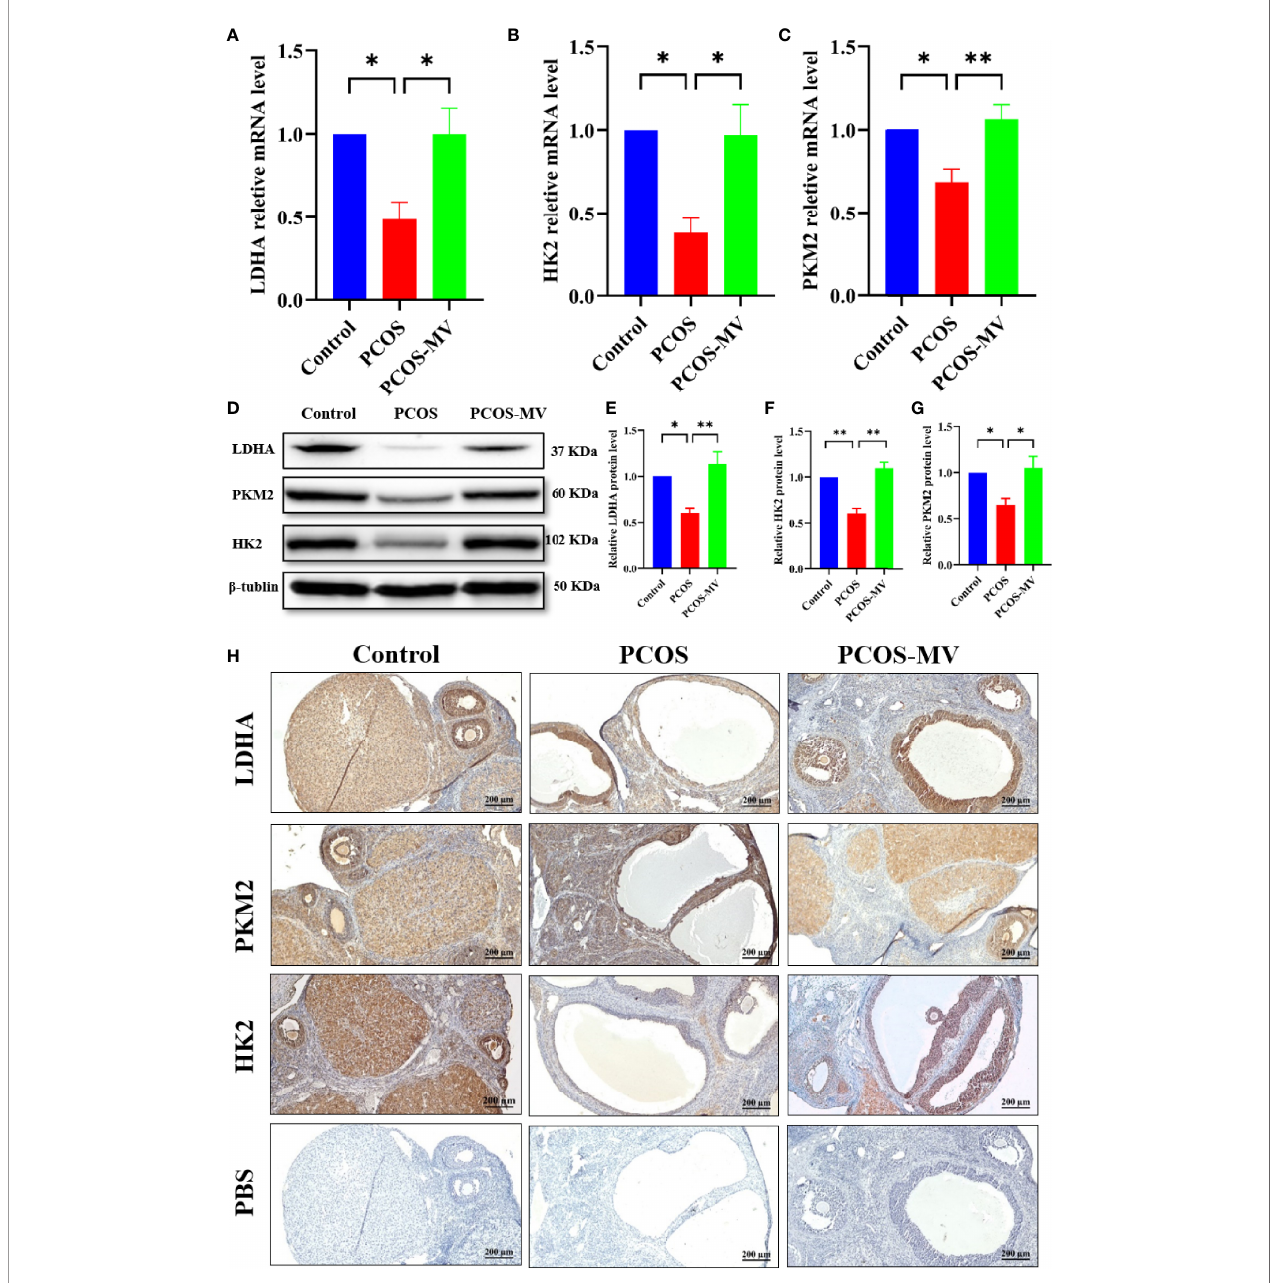
FIGURE 5 | Expression of LDHA, PKM2 and HK2 in ovarian tissues. (A) Relative Ldha mRNA level of ovaries (n = 4 rats per group). (B) Relative Pkm2 mRNA level of ovaries (n = 4 rats per group). (C) Relative Hk2 mRNA level of ovaries (n = 4 rats per group). (D) Western blotting assays of LDHA, PKM2 and HK2 in ovarian tissues, with b -tubulin served as a loading control (n = 4 rats per group). (E) Relative LDHA protein level of ovaries (n = 4 rats per group). (F) Relative PKM2 protein level of ovaries (n = 4 rats per group). (G) Relative HK2 protein level of ovaries (n = 4 rats per group). (H) Immunohistochemistry assays of LDHA, PKM2 and HK2 in ovarian tissues (n = 4 rats per group), the lowest panel shows the negative control. Data were presented as mean ± SEM. Signi fi cant differences were respectively presented as * P < 0.05 and ** P <